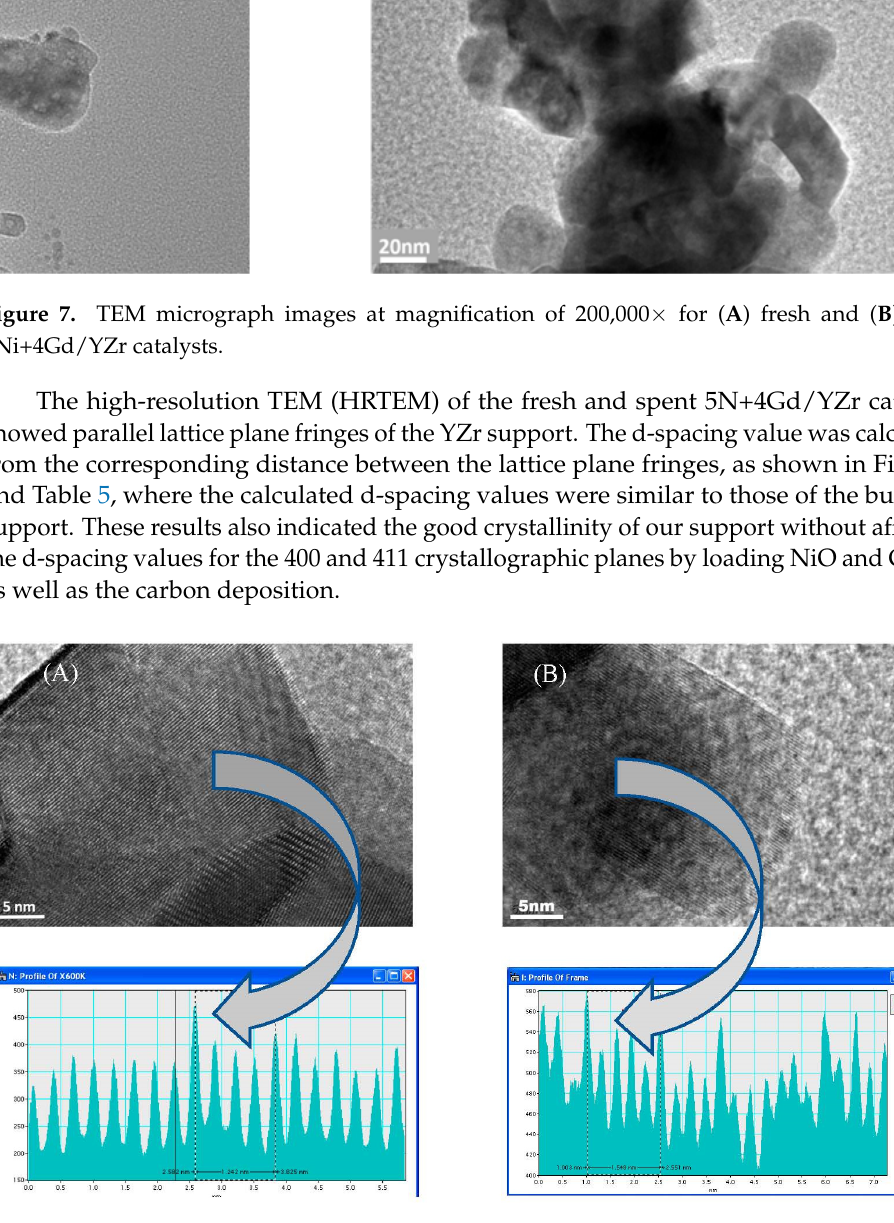
Figure 8. HRTEM micrograph images at magnification of 600,000 × for ( A ) fresh and ( B ) spent 5Ni+4Gd/YZr catalysts. Table 5. d-spacing calculated from HRTEM for both fresh and spent 5Ni+4Gd/Yzr.